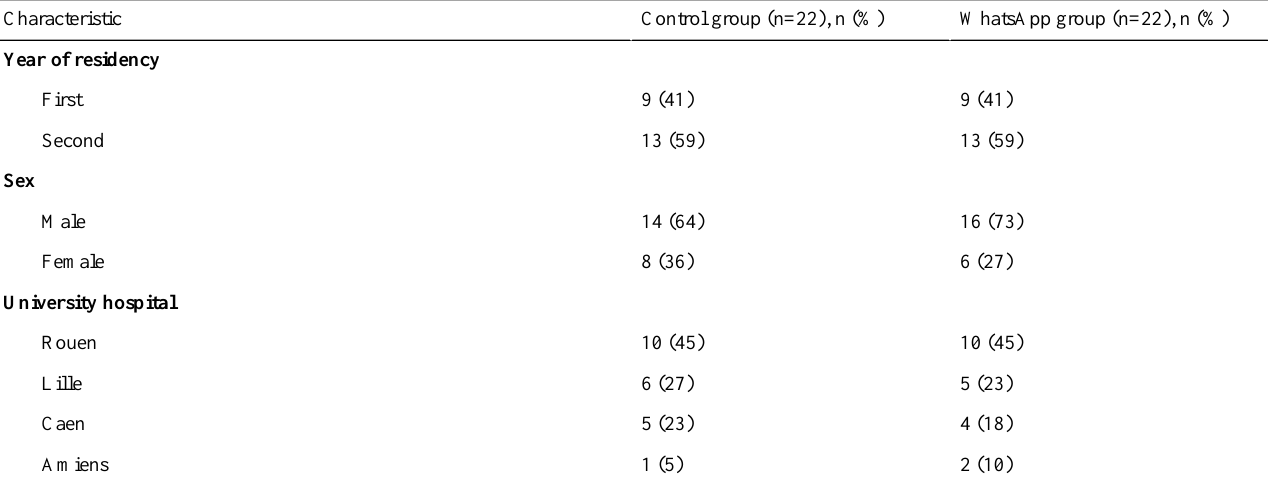
Table 3. Demographic characteristics of residents who answered the final evaluation.